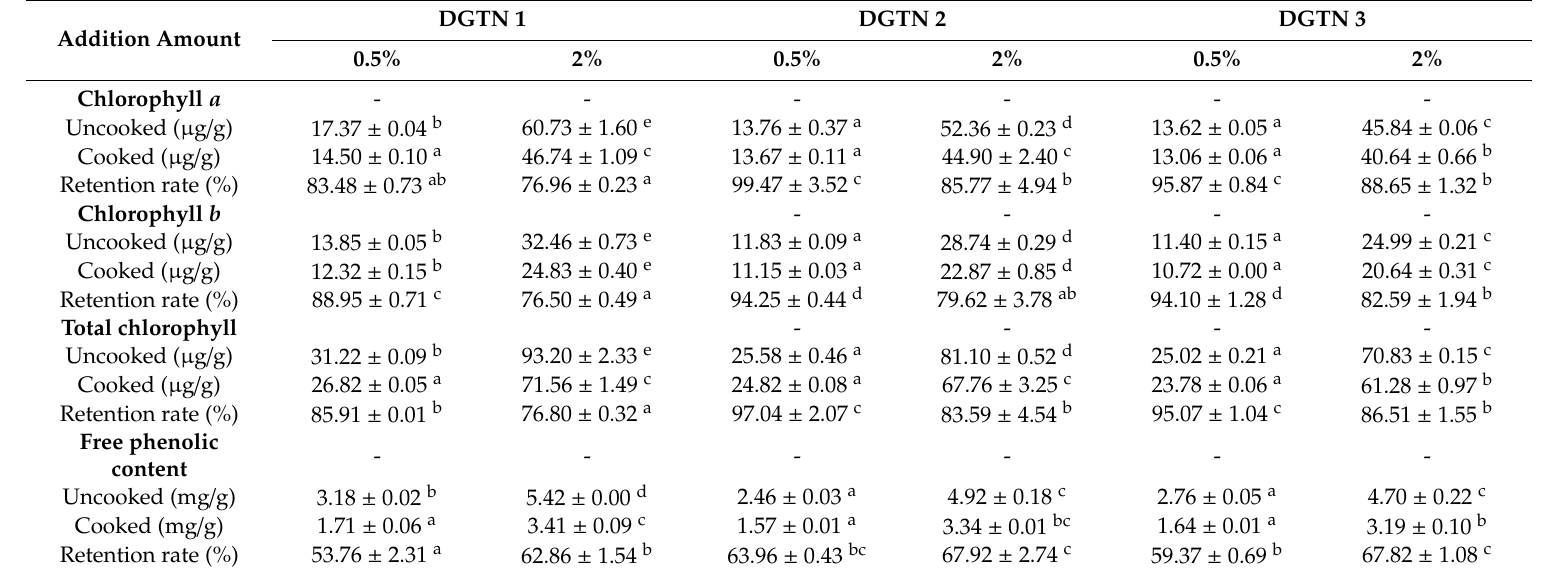
Table 2. Functional chemical component changes of DGTNs before and after water